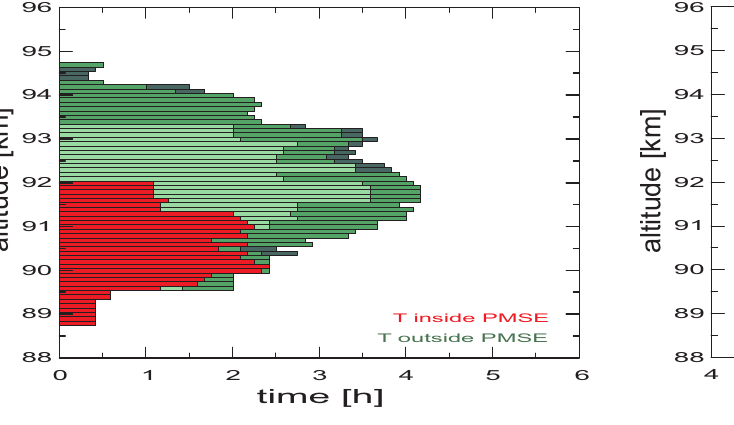
Fig. 4. Analysis of the time periods when supersaturation occurs. The dark green (red) bars shows the total time outside (inside) PMSE when the available time periods are sampled with a time slot of 15min. For the no-PMSE case we have repeated the procedure using a time slot of 30 (green) and 60 (light green) minutes.